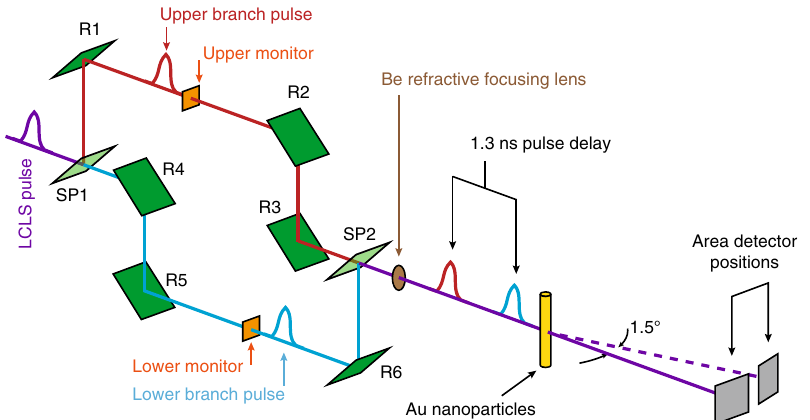
Fig. 1 Schematics of the hard X-ray delay line instrument. An incoming ultrashort X-ray pulse is split with a thin silicon single crystal splitter (SP1). The pulses are directed along different pathways via re fl ective Bragg optics (R1 – R6). The relative path length difference between the lower branch (LB) and the upper branch (UB) introduces a time delay Δ t (here 1.3 ns) between the split